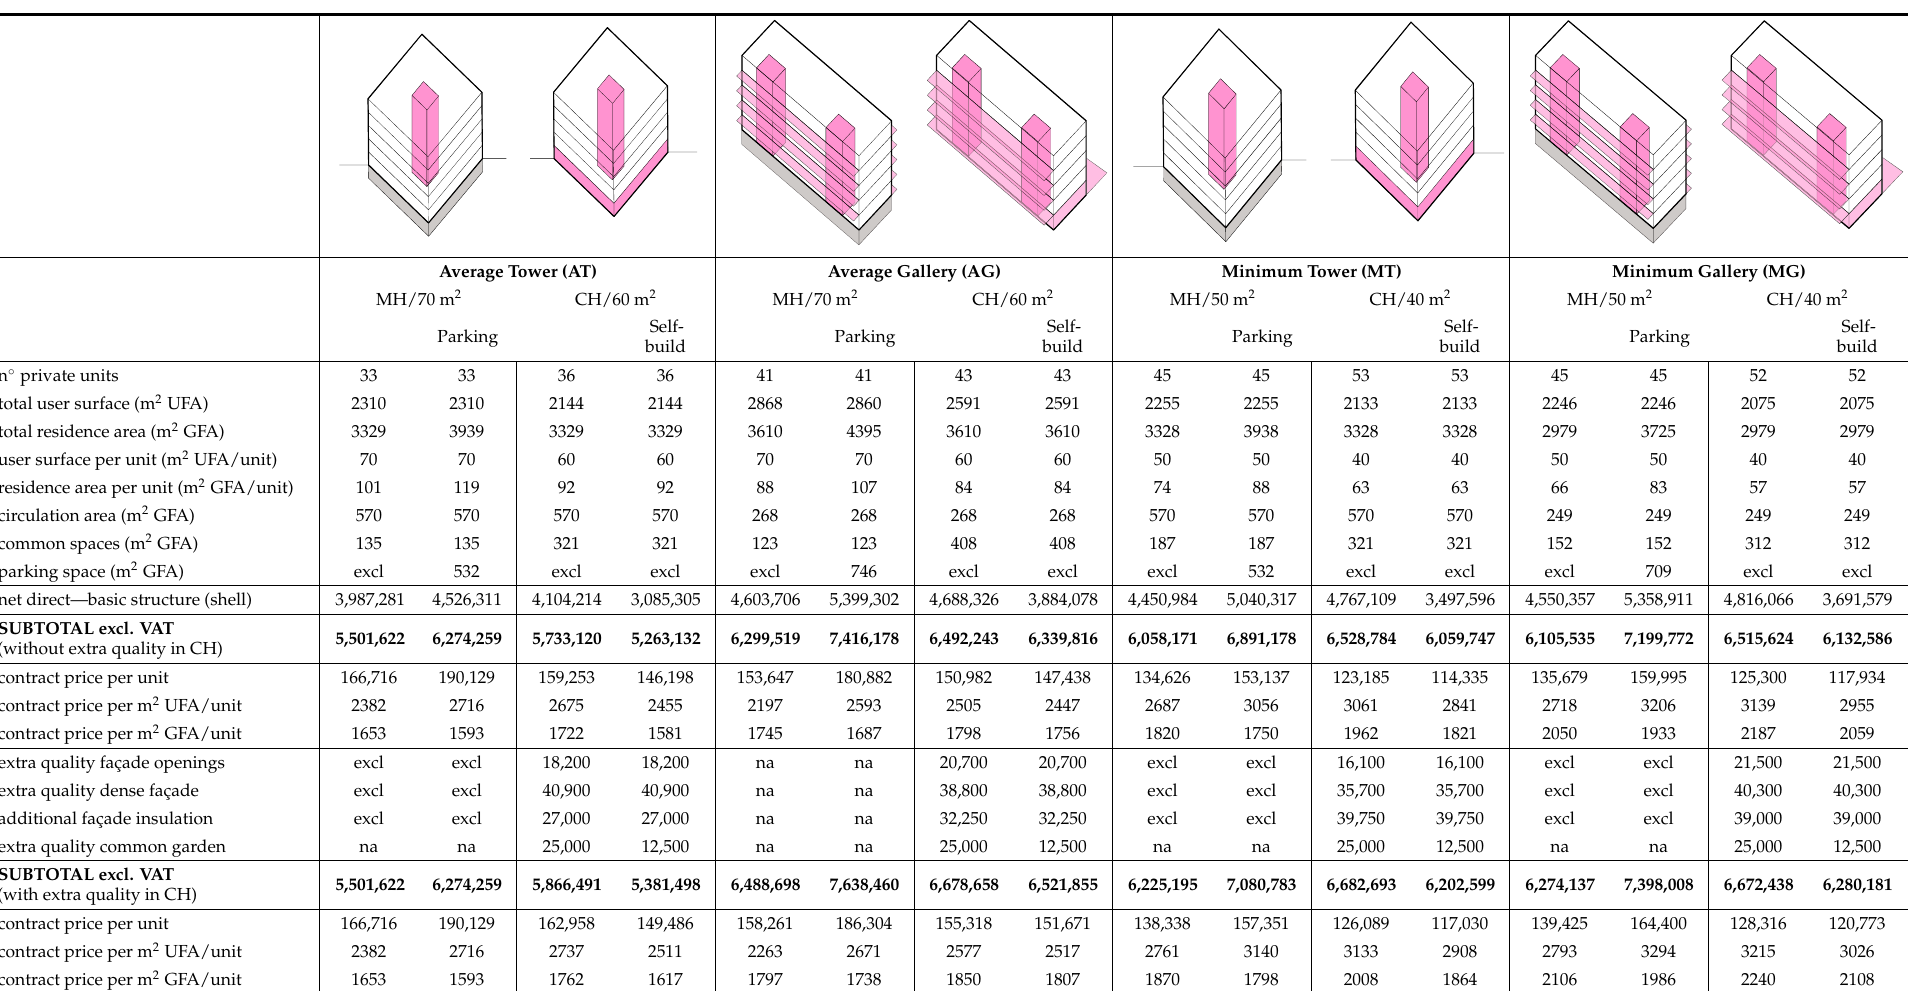
Table 2. Summary of the building costs simulation results (Source: courtesy of Casper Mouissie, edited by Authors).